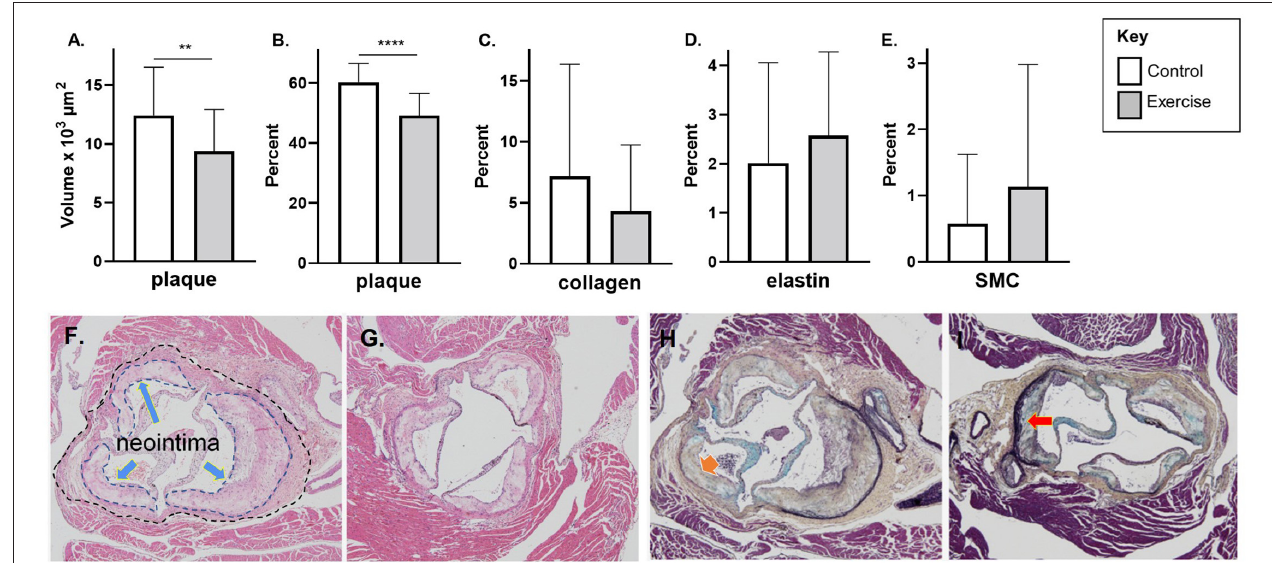
FIGURE 4 | The effect of exercise on plaque volume, degree of stenosis, and composition in a late-stage model of atherosclerosis. Chow fed apoE -/- mice with late-stage plaques were exposed to exercise for 10 weeks at 40 weeks of age. Aortic sinus sections were assessed for (A) plaque volume, (B) plaque % stenosis, (C) vessel elastin, (D) plaque collagen, and (E) plaque SMC content. Data are expressed as mean ± SD. The x -axis represents the control (white bar) vs. the experimental (gray bar). Representative H&E stain of the aortic sinus in the control (F) and exercise group (G) (The inner dotted line in 4F shows the area of plaque formation in this section; the outer dotted lines show the lumen area at the same level of the aortic sinus – refer to Methods for description of plaque volume and stenosis calculations). Representative H&E stain of the aortic sinus in the control (F) and exercise group (G) . Representative Movat’s stain of the aortic sinus in the control (H) and exercise group (I) . with magnification x 600. Arrows represents collagen (H) and elastin (I) . * p < 0.05, ** p < 0.01. Data are expressed as mean ± SD. SMC, smooth muscle cell. ** p < 0.01, **** p <